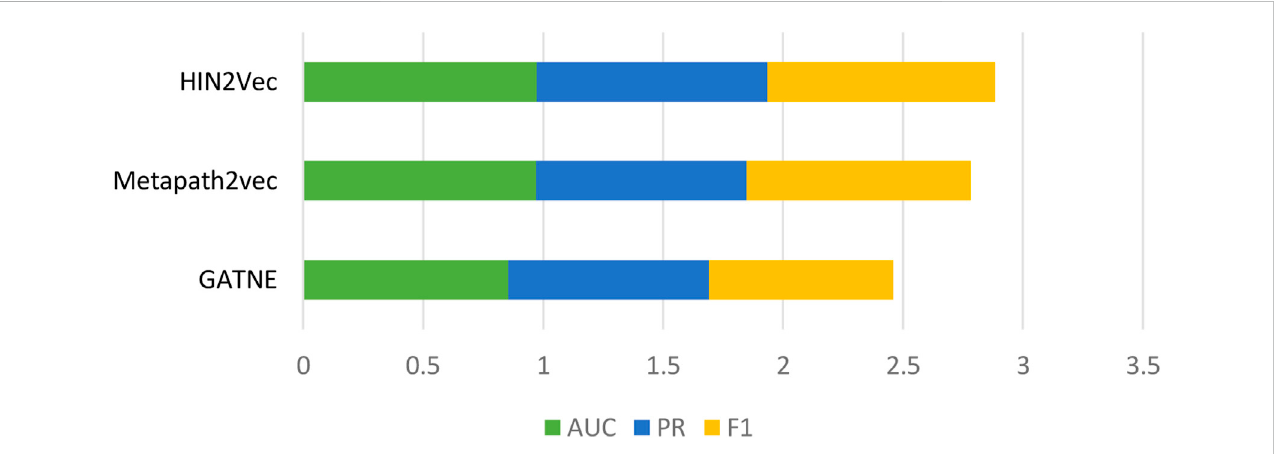
FIGURE 3 Graph embedding methods comparison.